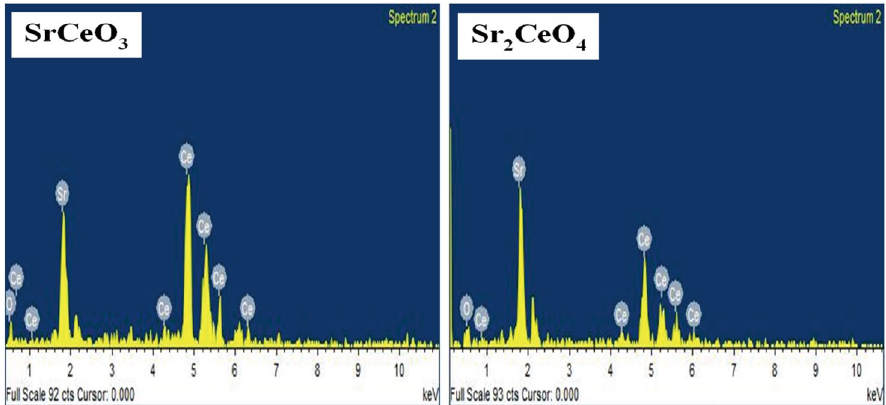
Fig. 5 EDX spectra of fracture surfaces of sintered